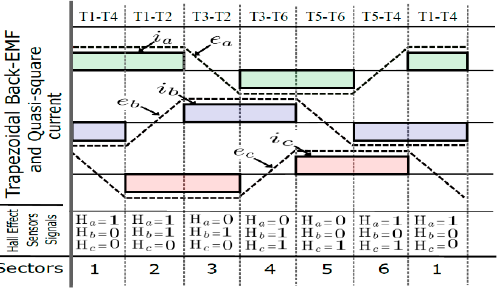
Figure 2. Trapezoidal electromotive forces (back-EMFs), phase currents, Hall effect sensor signals, and MOSFET states.